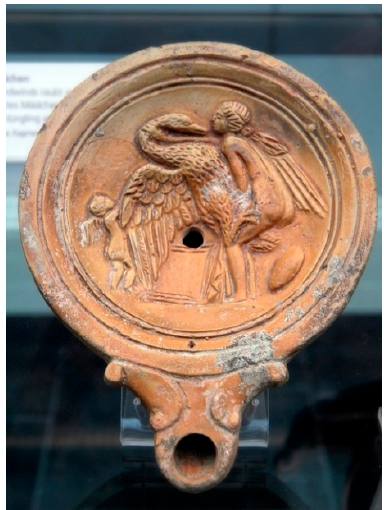
Figure 4. Terracotta Roman oil lamp of Leda and the Swan , C1st A.D., © Staatliche Antikensammlun- gen,